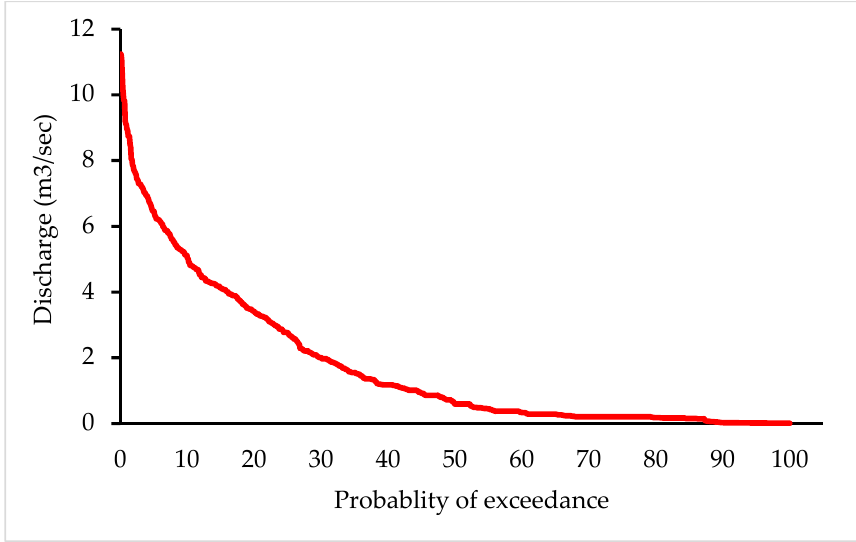
Figure 9. Flow duration curve (FDC) for Brantie river using 2015 to 2017 streamflow data.